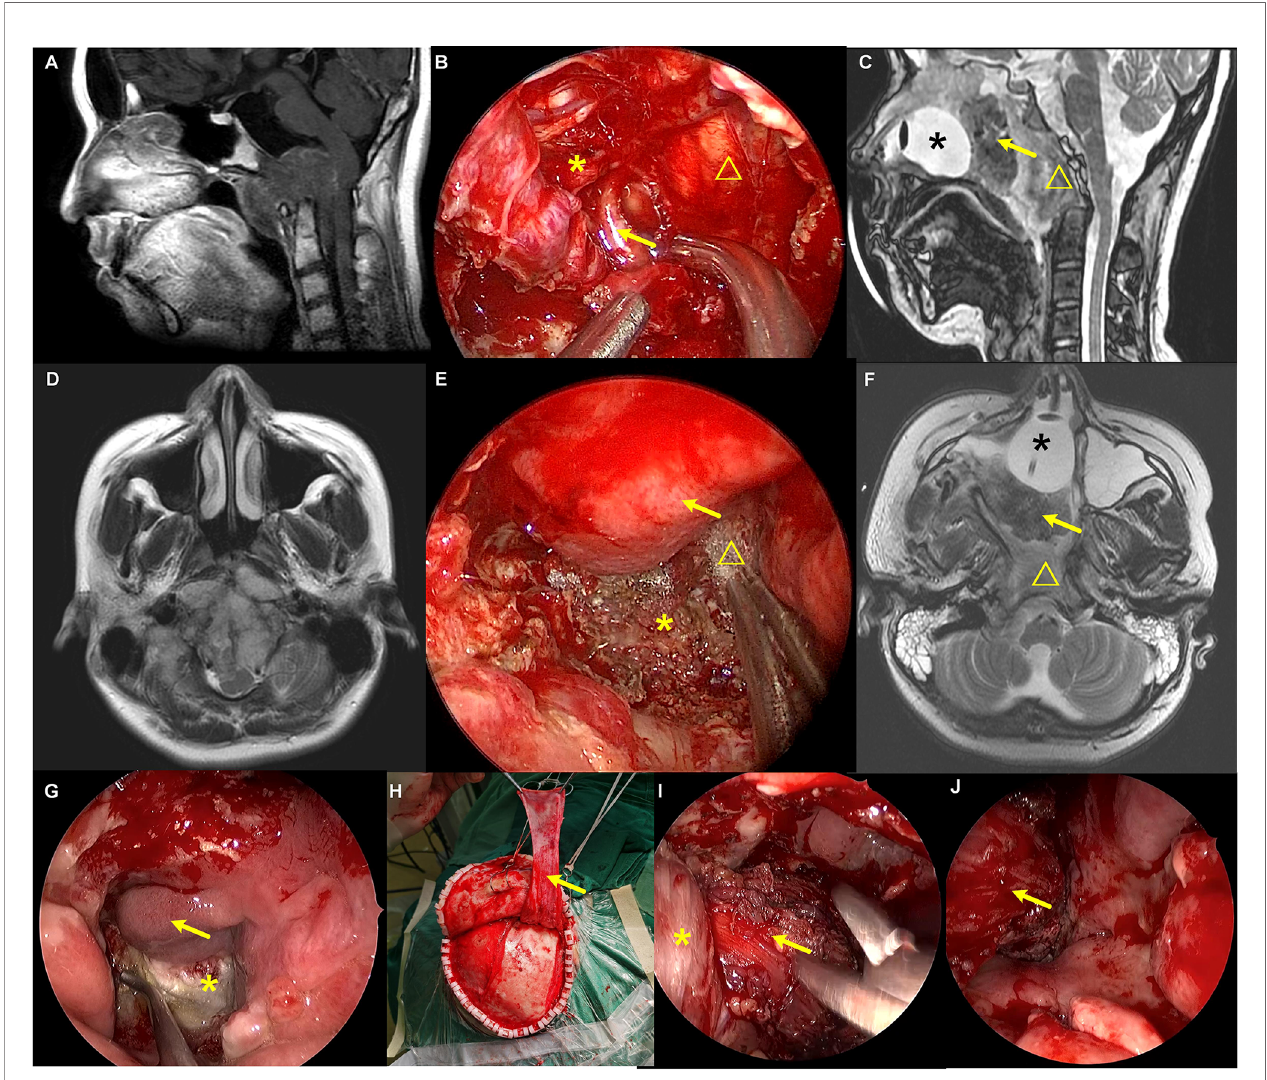
represents the nasoseptal fl ap. Asterisk represents the tip of the odontoid. Triangle represents the fascia lata. (C, F) Postoperative images after the tumor resection and three CSF leakage repairing surgeries. Asterisk represents the balloon of the urethral catheter. Arrow represents the iodoform gauze. Triangle represents